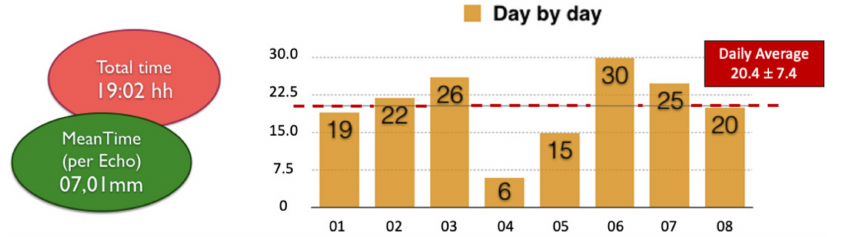
Figure 1. General RHD screening data. This figure reports the total time spent performing the echocardiographic screening on the whole population (red circle) and the mean time spent per exam (green circle). On the right side of the figure, a diagram shows the number of echocardio- graphic examinations performed per day. Abbreviations: RHD: rheumatic heart disease; hh: hours; mm: minutes.